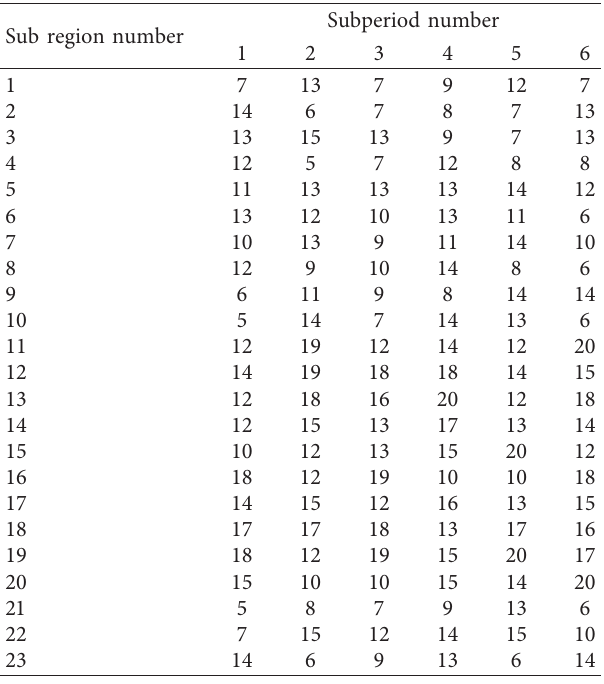
Table 7: The minimum number of riders required for each sub- region and each period of the whole delivery day.